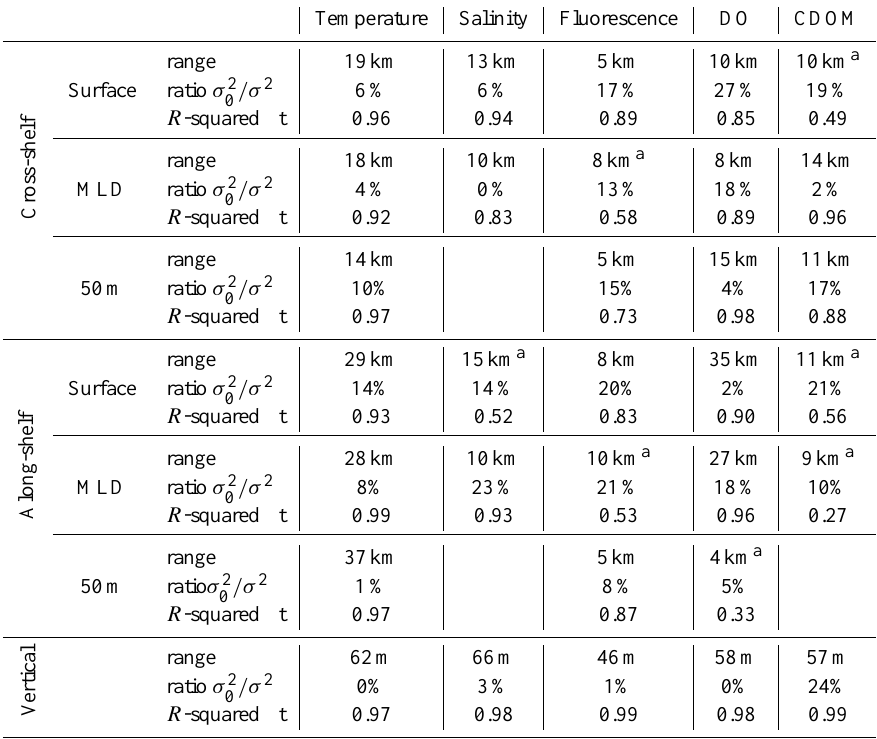
Table 1. Spatial scales of variability for spherical fit to semivariograms for different parameters and depths across, along the shelf and along /σ 2 ), and R squared for the model fit to experimental values are indicated the vertical. The range, percentage ratio of the nugget to the sill ( σ 2 0 (ranges with a correspond to R squared < 0.7). Blanks indicate unsuccessful fit to the spherical